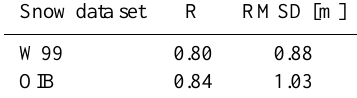
Figure 9. Sensitivity of sea ice thickness obtained from RA sea ice freeboard sea ice density and snow depth. (a) Sea ice thickness com- puted with Eq. (1) for different sea ice freeboard values (0.009m to 0.45m) and snow depth 0.3m as function of sea ice density. (b) Similar to (a) but computed for different snow depths (0m to 1.4m) and sea ice freeboard 0.27m as function of sea ice